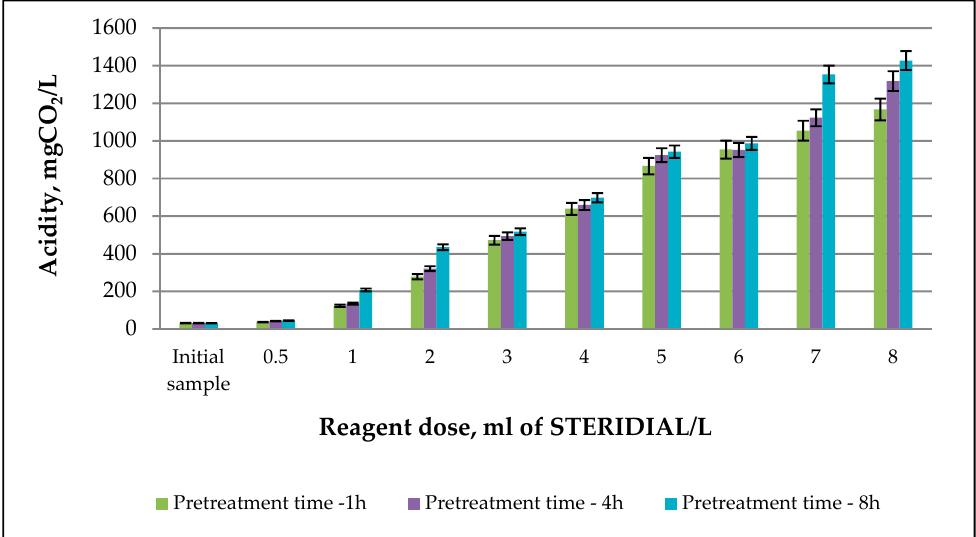
Figure 3. Changes in acidity determined in the sludge liquor subjected to 1, 4, and 8 h chemical disintegration of excess sludge vs. reagent dose.